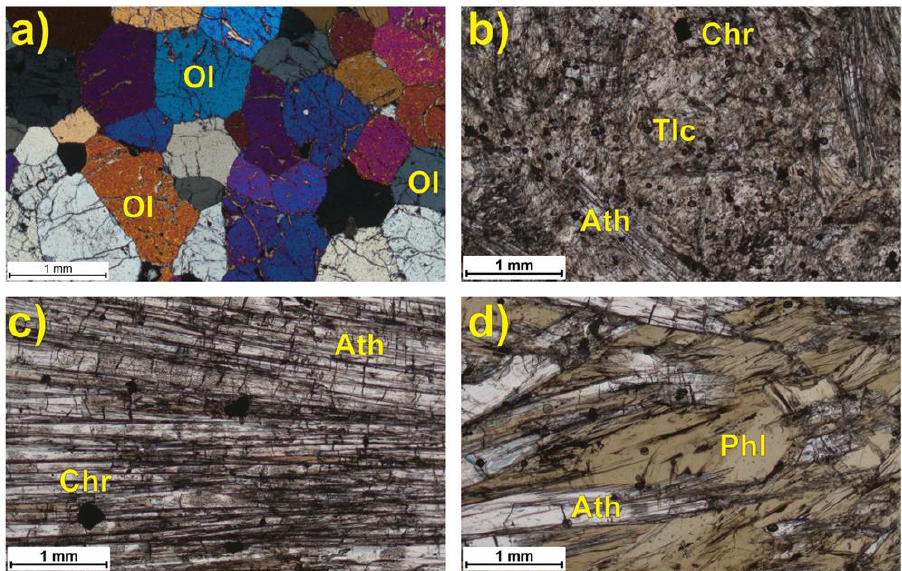
Figure 5. Microphotographs of the some of the samples of the present study. ( a ) Granoblastic dunite with distinct metamorphic texture in cross-polarized light. ( b ) Talc-dominated metasomatic rock with small specs of chromite and fibrous anthophyllite seen in plane polarized light. ( c ) Coarse fibrous and strongly parallel anthophyllite with rare euhedral chromite grains seen in plane polarized light. ( d ) Mica-dominated metasomatic rock at the contact to the granitoid intrusive sheet. Amphibolite needles (anthophyllite) are present towards the dunite side of the reaction, whereas biotite dominates the trondhjemite side of the metasomatic zone. Thin section image seen in plane polarized light. Abbreviations: Ant (anthophyllite), Chr (chromite), Phl (phlogopite), Ol (olivine), Tlc (talc). Minerals 2020 , 10 , 85